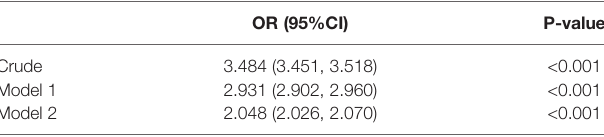
MAFLD, metabolic dysfunction-associated fatty liver disease. Model 1: adjusted for age and sex. Model 2: adjusted for age, sex, low-density lipoprotein cholesterol (LDL-C), fasting blood glucose (FBG), alanine aminotransferase (ALT), blood urea nitrogen (BUN), systolic blood pressure (SBP), triglycerides